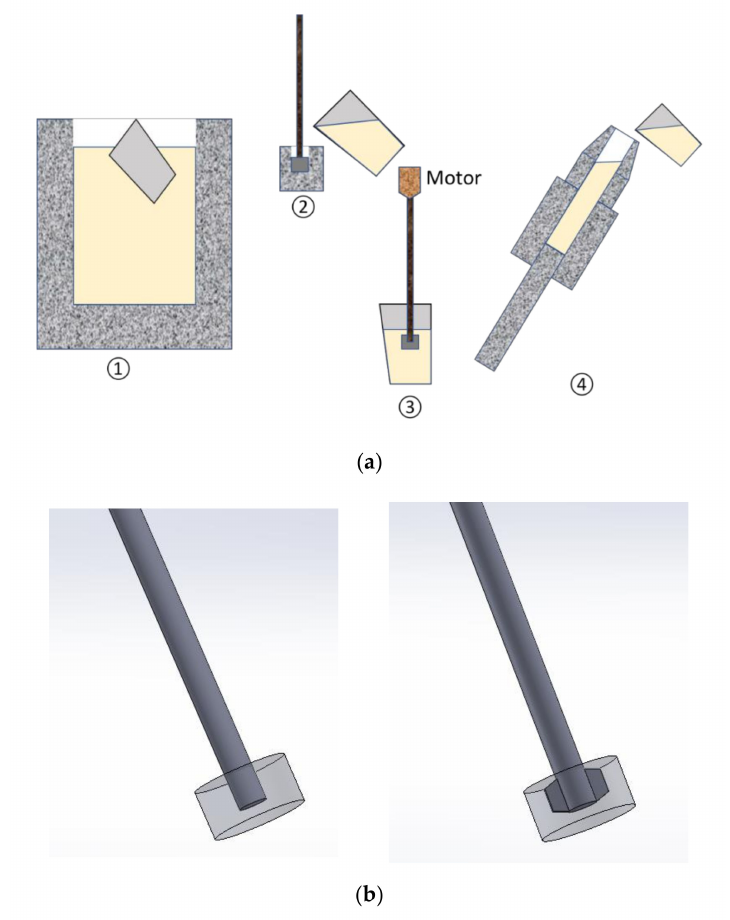
Figure 1. Schematic illustration of the slurry fabrication process with; ( a ) The RheoMetal TM process steps as (cid:192) Ladling, (cid:193) Casting the Enthalpy Exchange Material (EEM), (cid:194) Stirring in the solid EEM to make the slurry, (cid:195) Pouring the slurry into the shot chamber, and ( b ) Standard RheoMetal TM processing rod and EEM (Left) and Intense shearing set-up with wings added to the rod cast into the EEM body